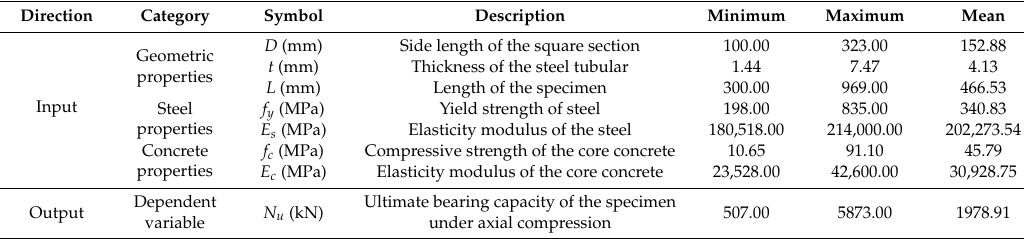
Table 1. Statistics of model input and output